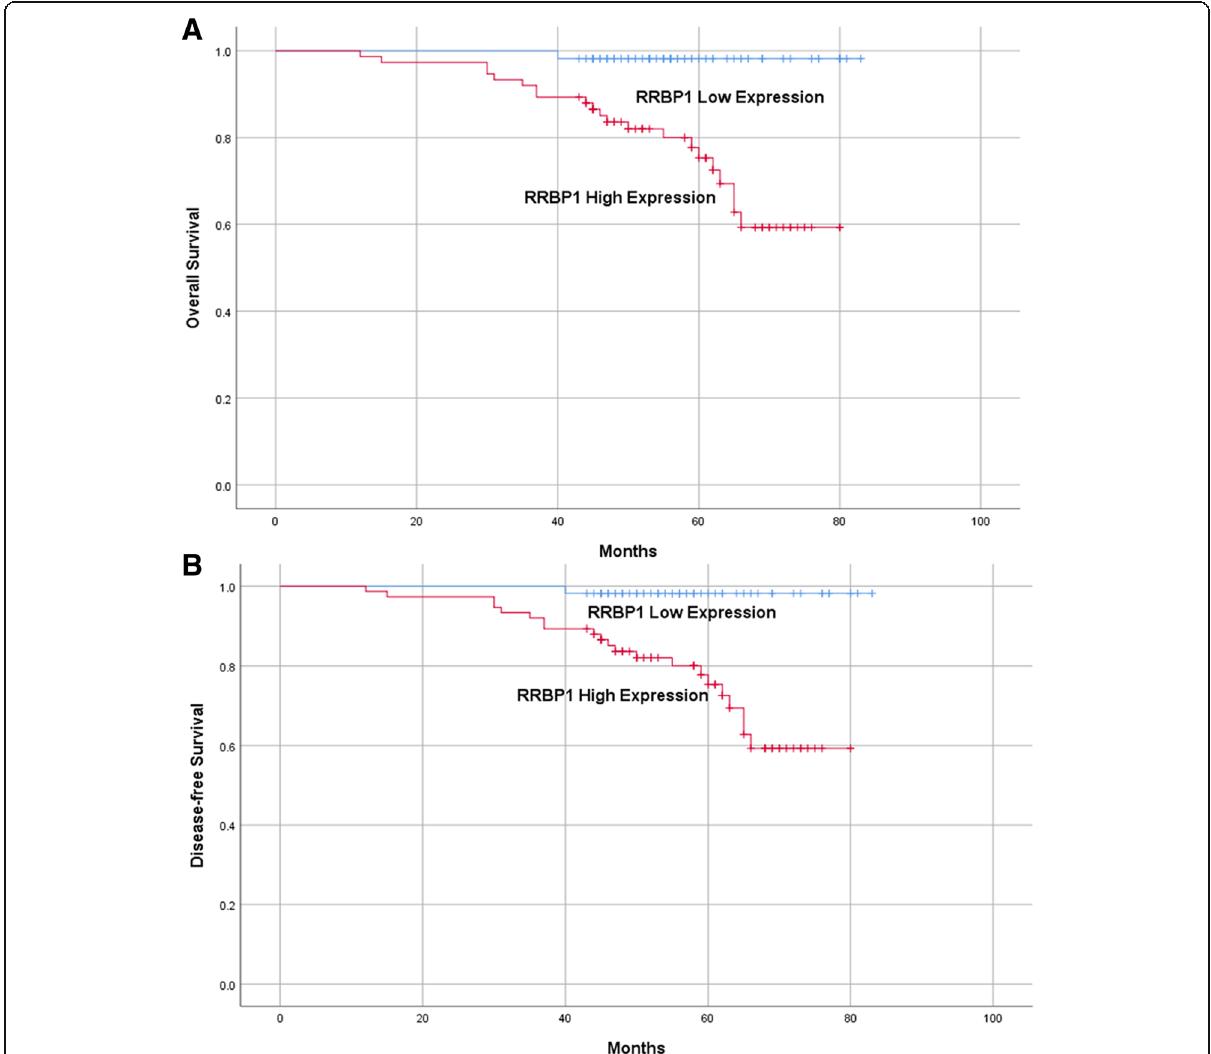
Fig. 3 Kaplan-Meier analysis of overall survival and disease-free survival related to the expression of RRBP1. Patients with high expression of RRBP1 had a poorer prognosis than those of patients with low expression of RRBP1. a , overall survival curves of the EC according to their RRBP1 expression status, P = 0.001; b , disease-free survival curves of the EC patients according to their RRBP1 expression status, P < 0.001